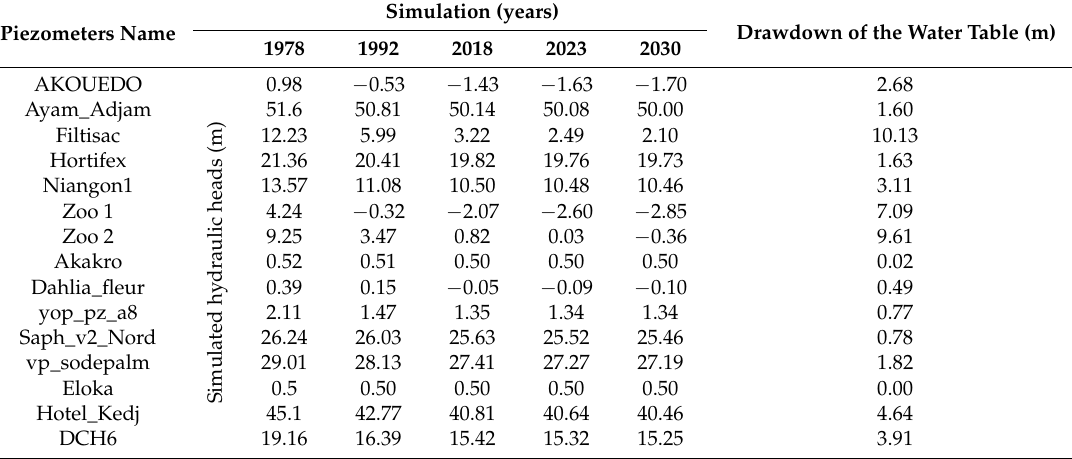
Table 3. Simulated drawdowns of the water table level from 1978 to 2030 at piezometer locations. Piezometers Simulation (years)